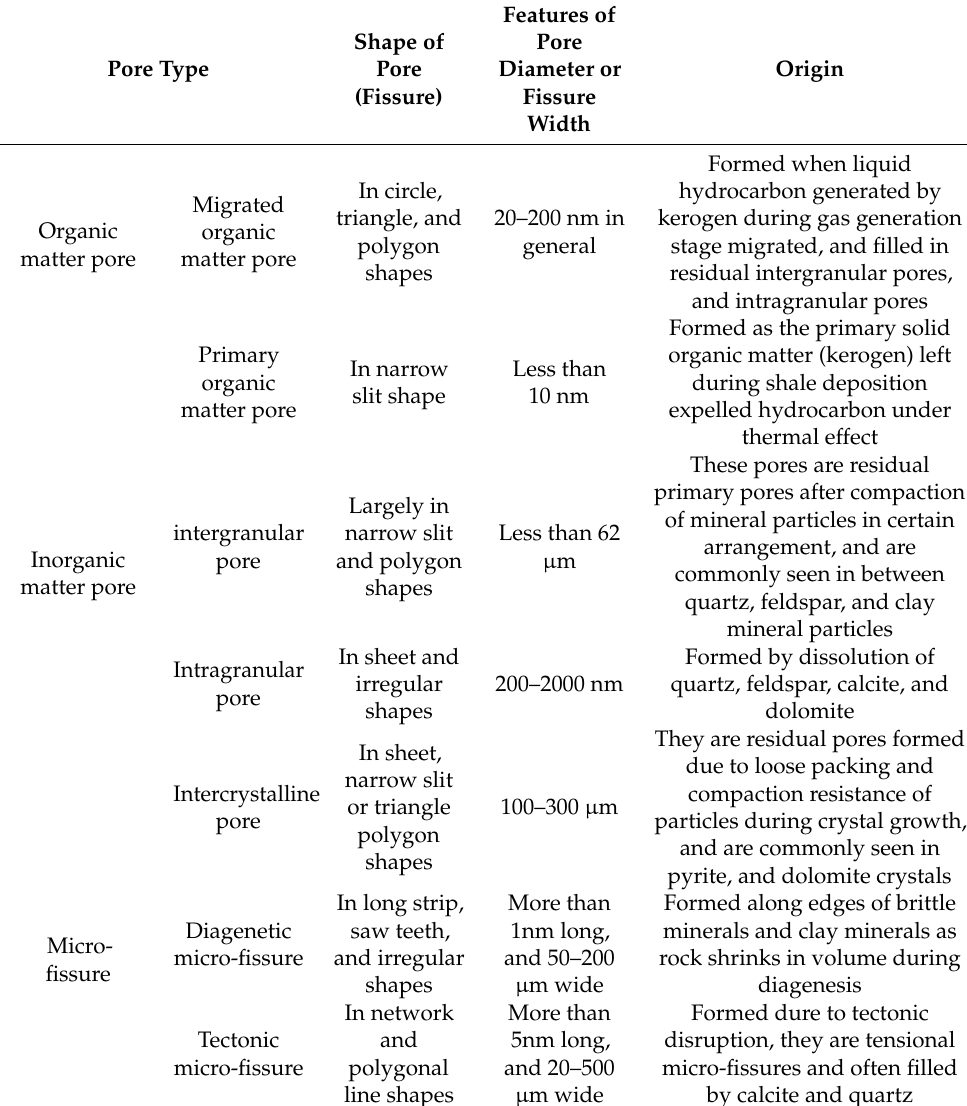
Table 3. Description of different types of reservoir space in shale reservoirs of Da’an area, southern Songliao